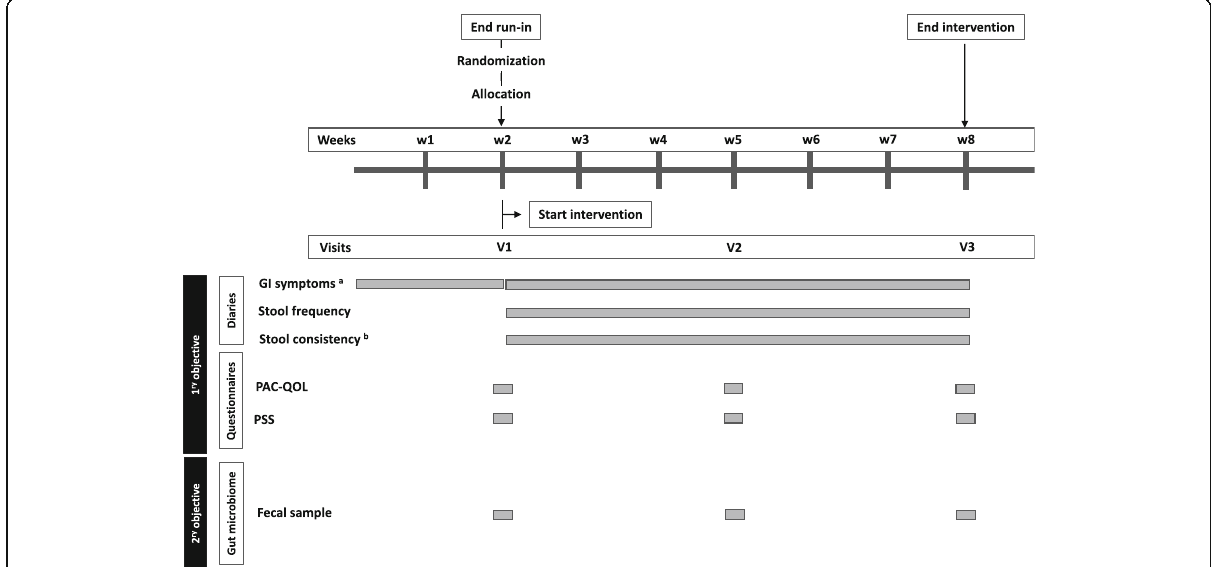
Fig. 2 Schematic diagram of primary and secondary objectives and instruments used for data/sample collection. Legend: GI, gastrointestinal; PAC-QOL, Patient Assessment of Constipation Quality of Life; PSS, Perceived Stress Scale. a Gastrointestinal symptoms were assessed by asking the volunteers to grade daily in the evening the average severity over the previous 24 h on a 5-point scale from 0 (not at all) to 4 (extremely) for the following 5 GI characteristics: bloating/distension, passage of gas, GI rumbling, feeling of fullness and abdominal discomfort. b Stool